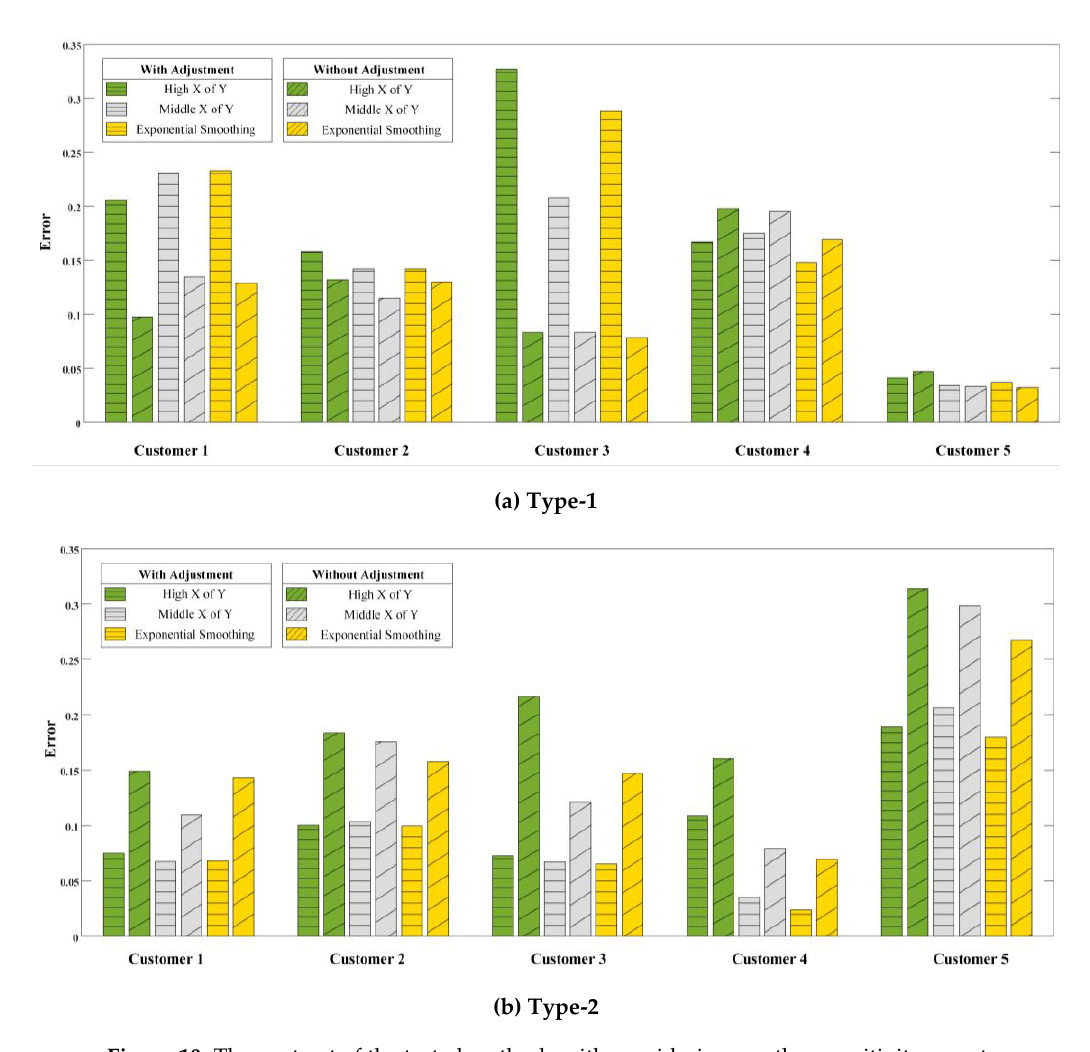
Figure 10. The contrast of the tested methods with considering weather sensitivity or not.